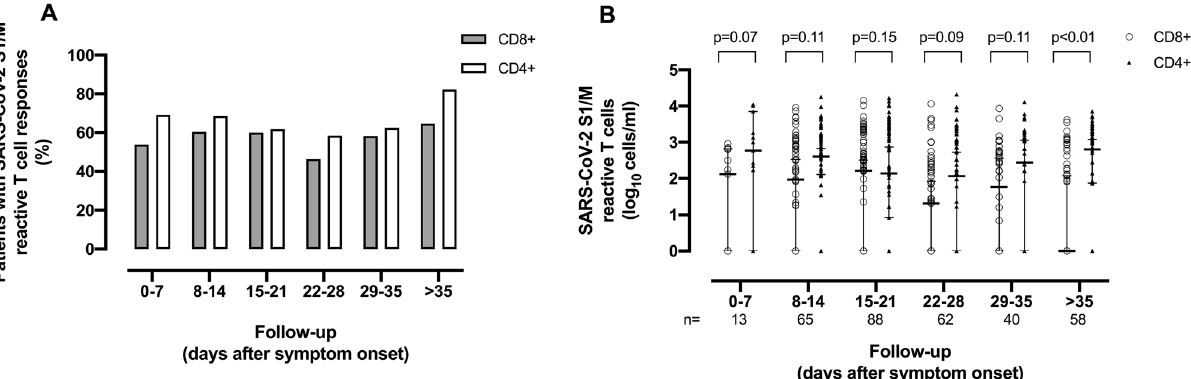
Figure 1. SARS-CoV-2 S1/M-reactive IFN-γ T-cell responses in critically ill COVID-19 patients, as determined by flow cytometry for intracellular staining. ( A ) Percentage of patients displaying detectable SARS-CoV-2- reactive CD8 + and CD4 + T-cell responses at different times (weekly basis) since symptom onset. ( B ) SARS-CoV- 2-reactive CD8 + and CD4 + T-cell counts at different arbitrarily defined time windows since symptom onset. Bars represent medians and 95% CI values. P values for comparisons are